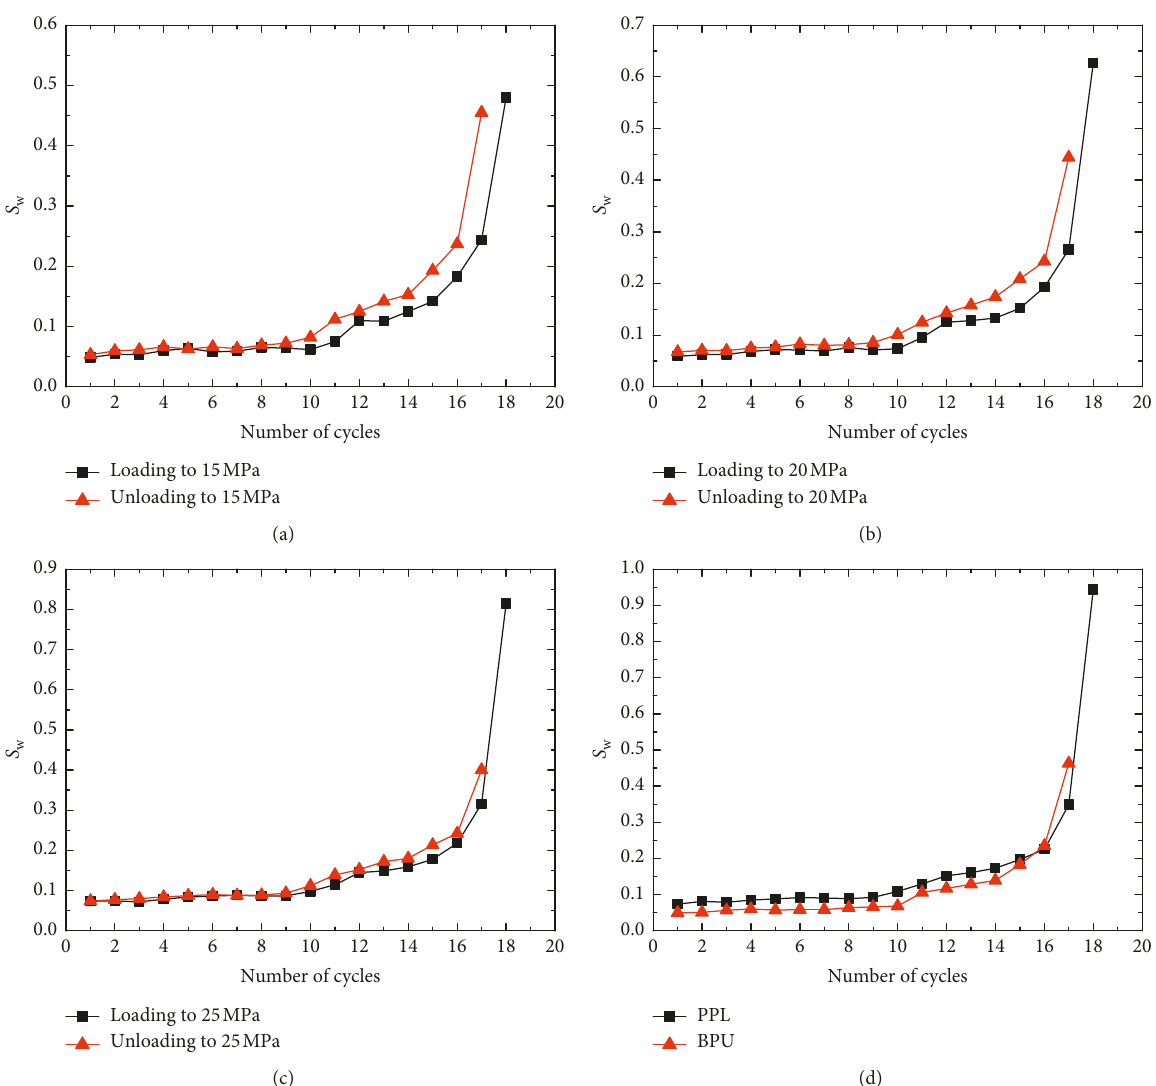
Figure 8: Evolution curves of S w under the same stress: (a) loading or unloading to 15MPa; (b) loading or unloading to 20MPa; (c) loading or unloading to 25MPa; (d) PPL or